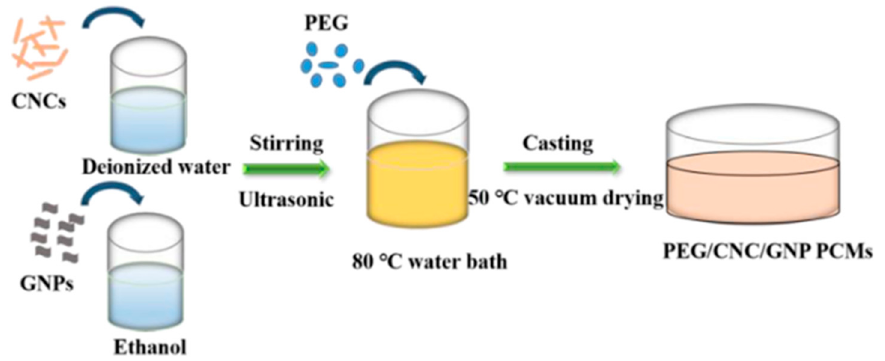
Figure 13. Sample preparation approach followed by Wei et al. [100].